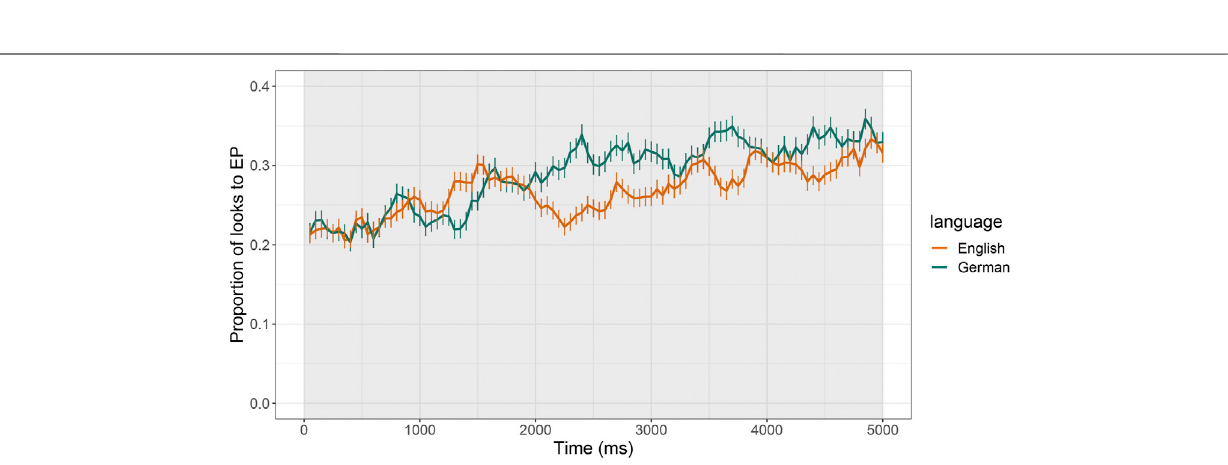
Frontiers in Virtual Reality |